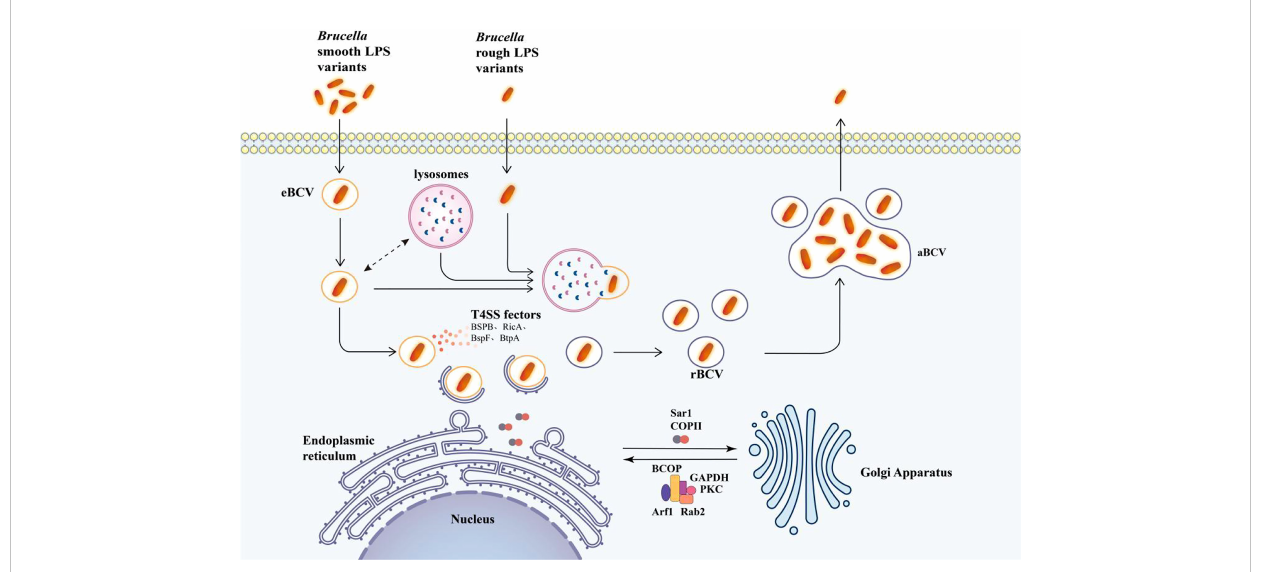
FIGURE 2 Model of intracellular transport of Brucella in macrophages. The lysosome interacts with eBCV and activates the transcription of T4SS effector proteins. T4SS effectors facilitate the arrival of eBCV at the endoplasmic reticulum exit site, and eBCV interacts with the surface coating of ERES to obtain the structural and functional characteristics of ER to form rBCV. The autophagy initiation proteins ULK1, ATG14L, and Beclin-1 play an important role in the formation of aBCV and fi nally release the pathogen from the cell. The mechanism of entry of Brucella rough LPS variants into cells is not clear, and after entering the cell, Brucella is degraded by lysosomal phagocytosis upon entry. The single arrows represent the fl ow of Brucella intracellular processes, and the double arrows represent interactions.